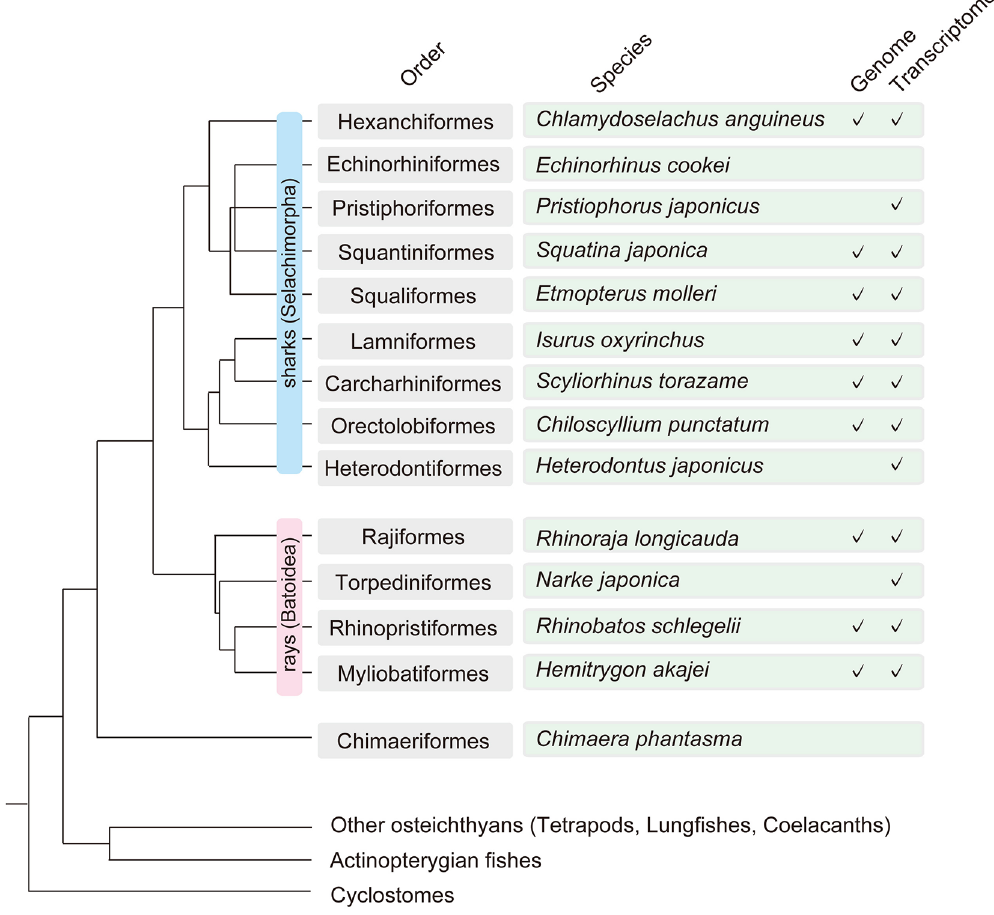
Figure 1. Chondrichthyan phylogeny and taxon sampling in the Squalomix Consortium. This figure includes some chondrichthyan species selected to represent the individual taxonomic orders that reflect the local fauna of Japan and are/will be analyzed by the consortium by genome or transcriptome sequencing (as of April 10, 2022). The full list of species and current status can be found in